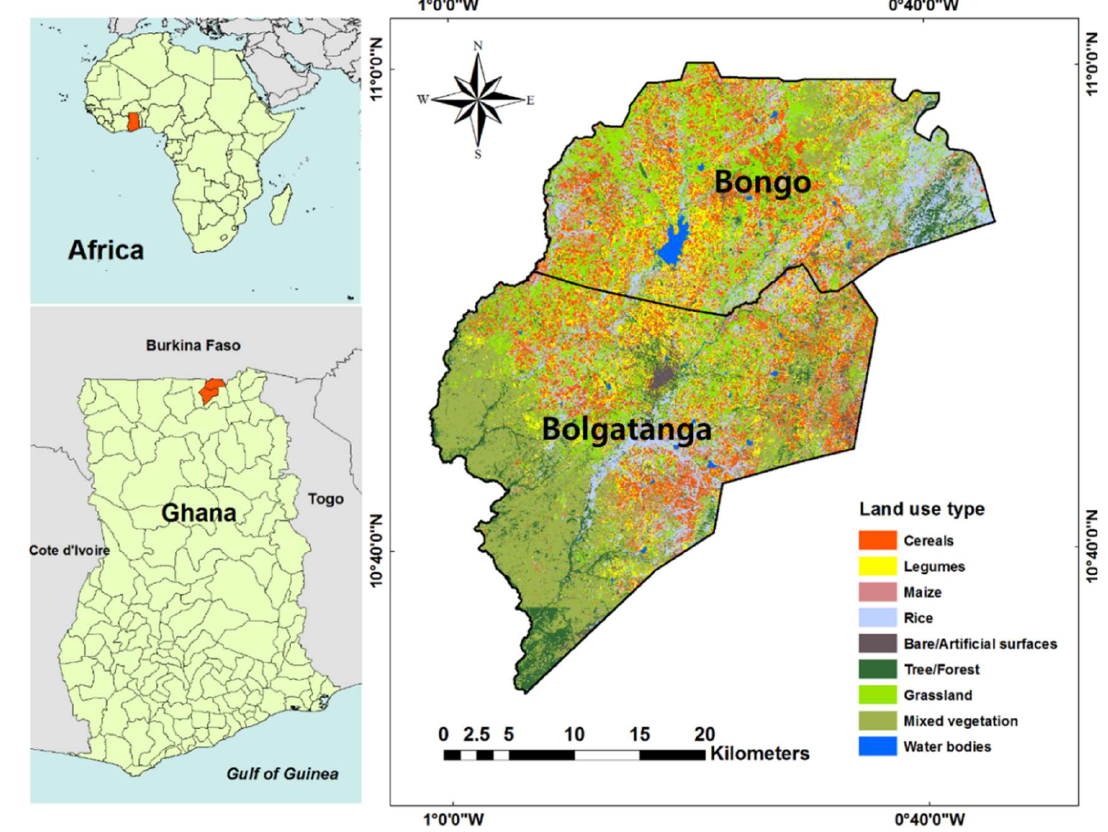
Figure 1. Location and land-use patterns of the study area in northern Ghana. The land-use classification is based on RapidEye images of 2013 with resolution of 25 × 25 m 2 . (Forkuor [52]). The description and the areal percentage of each land-use type are presented in Table S1 in the Supplementary Materials.